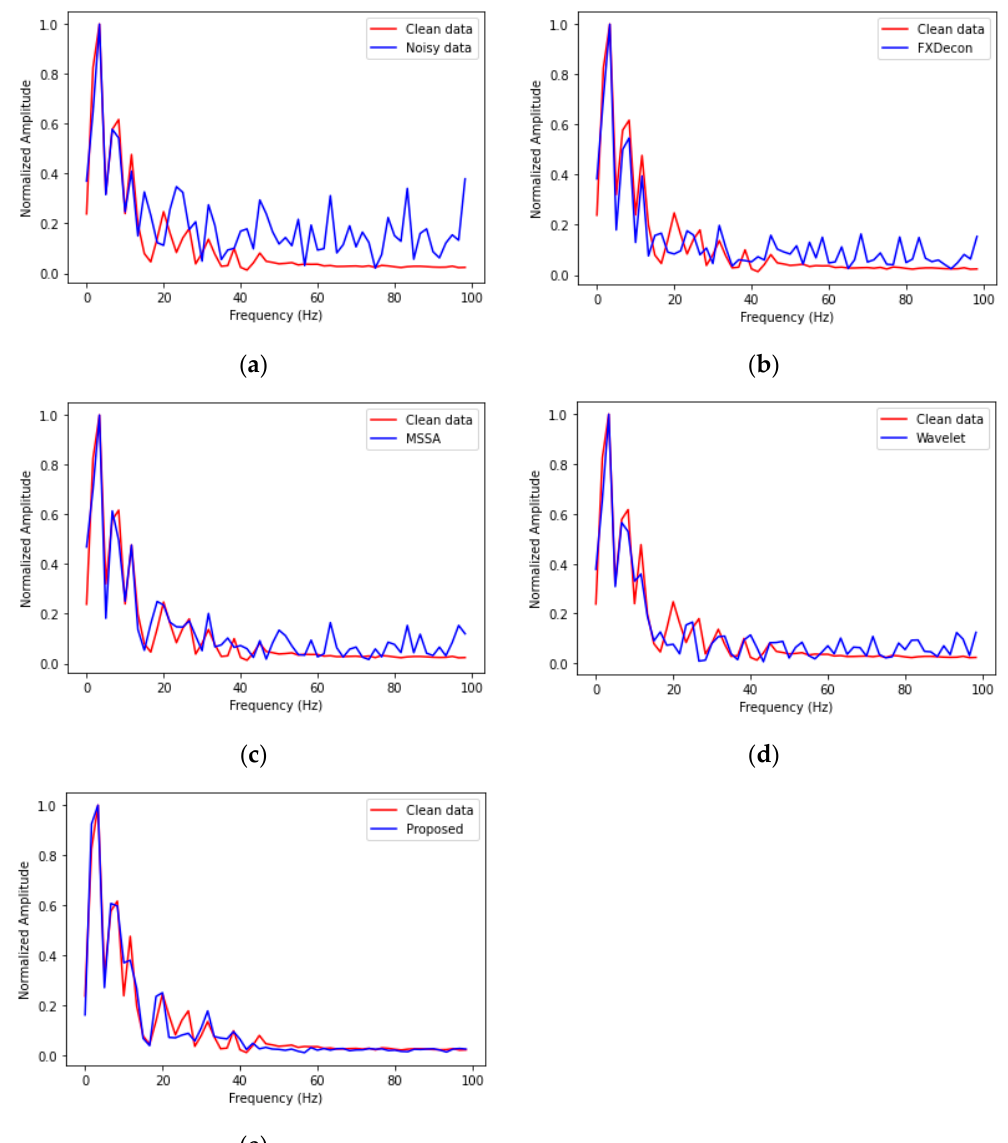
Figure 9. Frequency amplitude diagram. ( a ) Noise and clean signal comparison. ( b ) FXDECON and clean signal comparison. ( c ) MSSA and clean signal comparison. ( d ) Wavelet and clean signal comparison. ( e ) The proposed method and clean signal comparison. The frequency amplitude spectrum curve of the original signal is indicated in red, whereas the frequency amplitude curve of the denoising result is indicated in